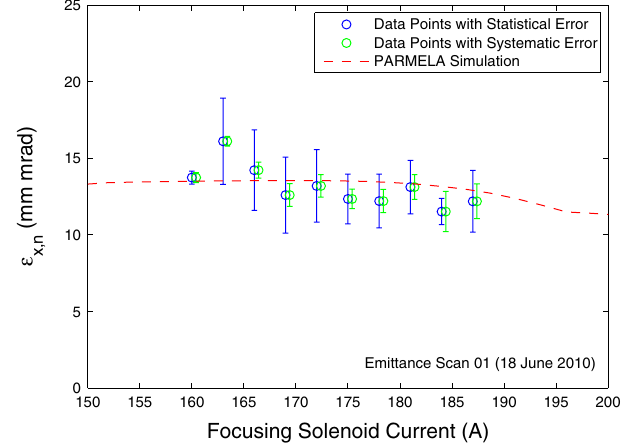
FIG. 8. The comparison of the statistical and the systematic errors on the multislit method for the emittance scan as a function of the